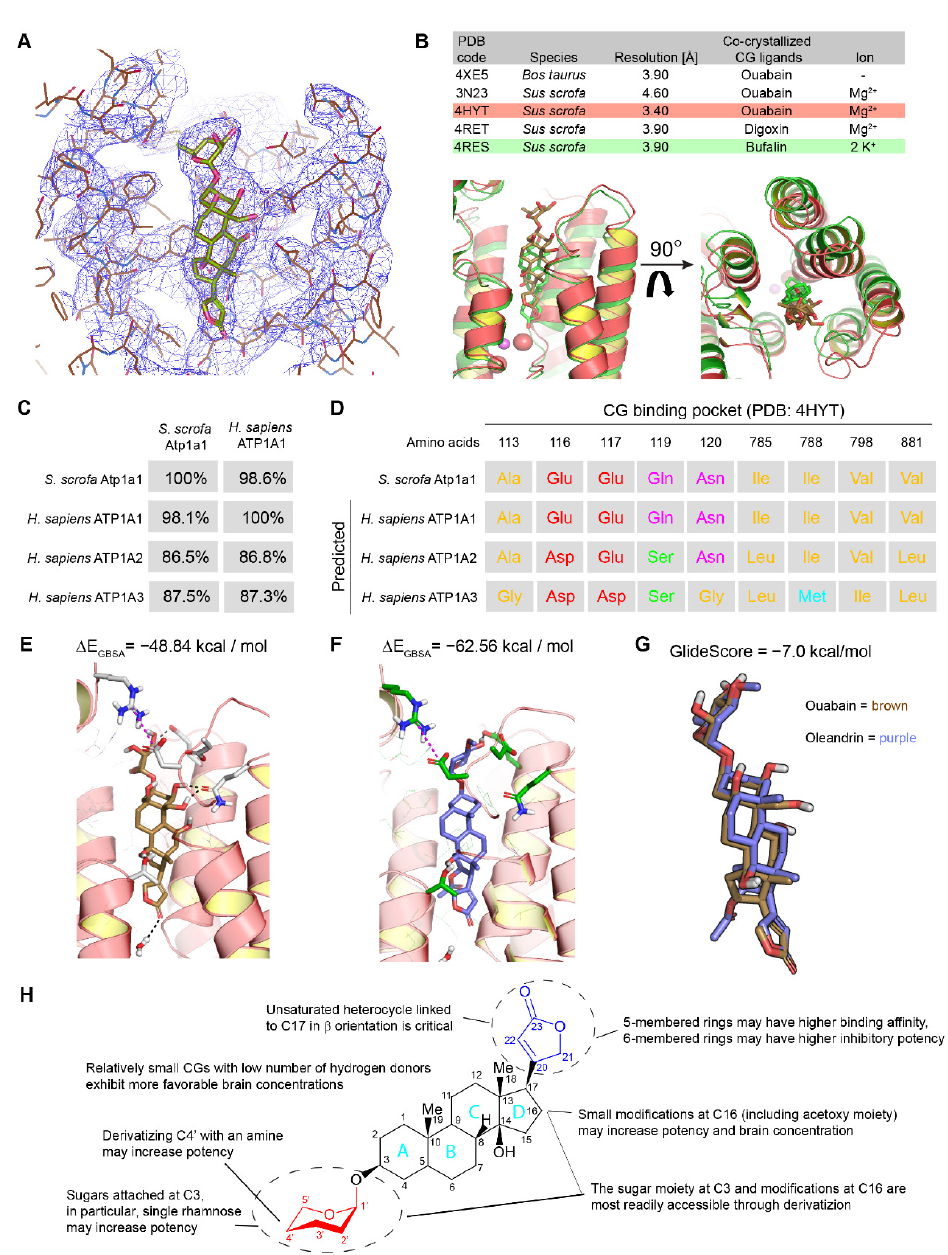
Figure 2. In silico prediction of CG binding pose within relevant human NKA α subunits and summary of key CG design considerations. ( A ) Electron densities of CG binding pose in PDB entry 4HYT [41]. ( B ) Structural alignment of ouabain (brown) and bufalin (green) within the CG binding pocket of two well-resolved X-ray crystallography models (PDB entries 4HYT and 4RES [47]) of NKAs. ( C ) Sequence identities between porcine and human NKA α subunits known to be